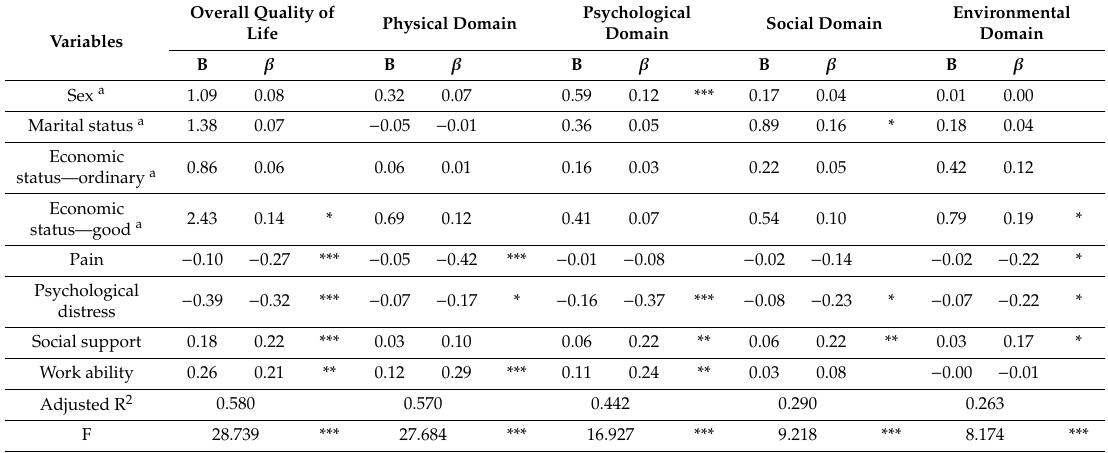
Table 4. Summary of multiple linear regression predicting the quality of life and its